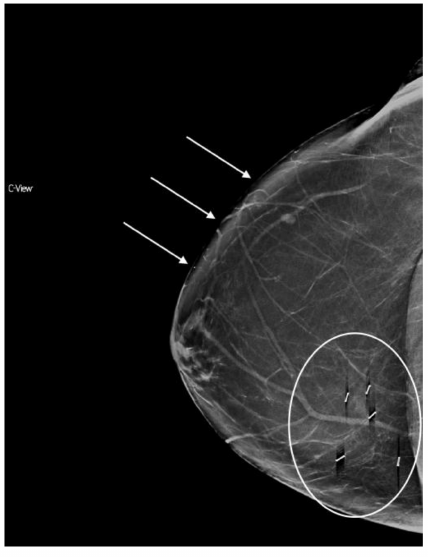
Figure 8. “Slinky”/shadowing clip artifact (circled) and skin burnout (arrows) on synthesized